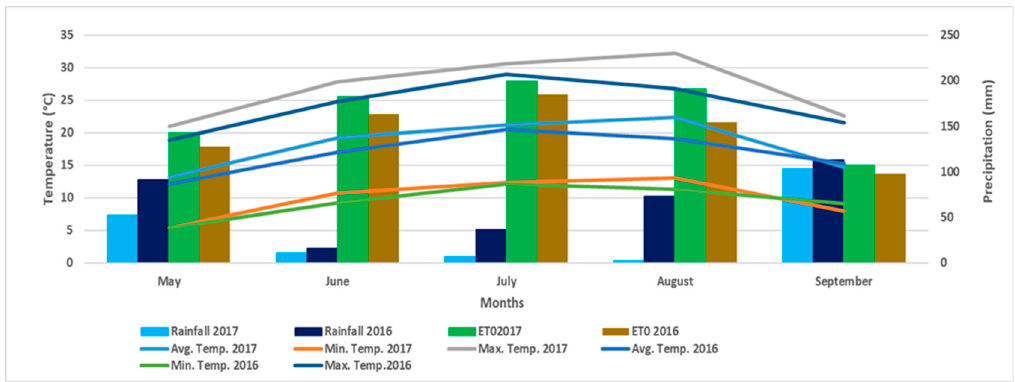
Figure 5. Climatic trend relative to the two years of test, 2016 and 2017.